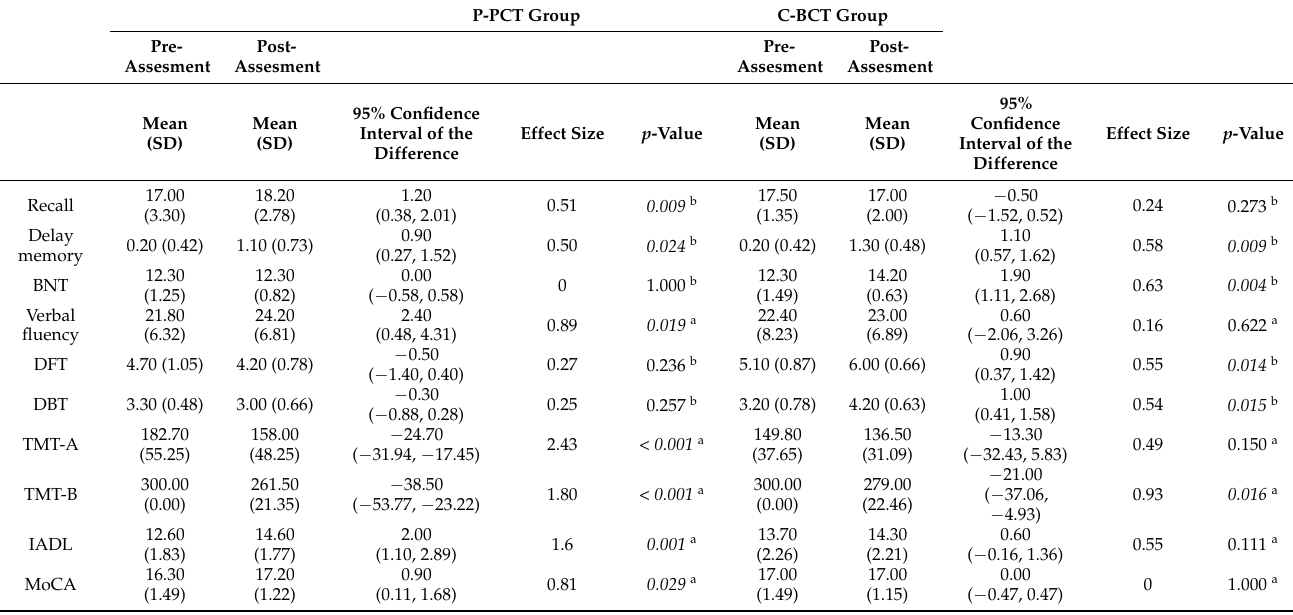
Table 3. Pre- and post-assessment scores of the groups.